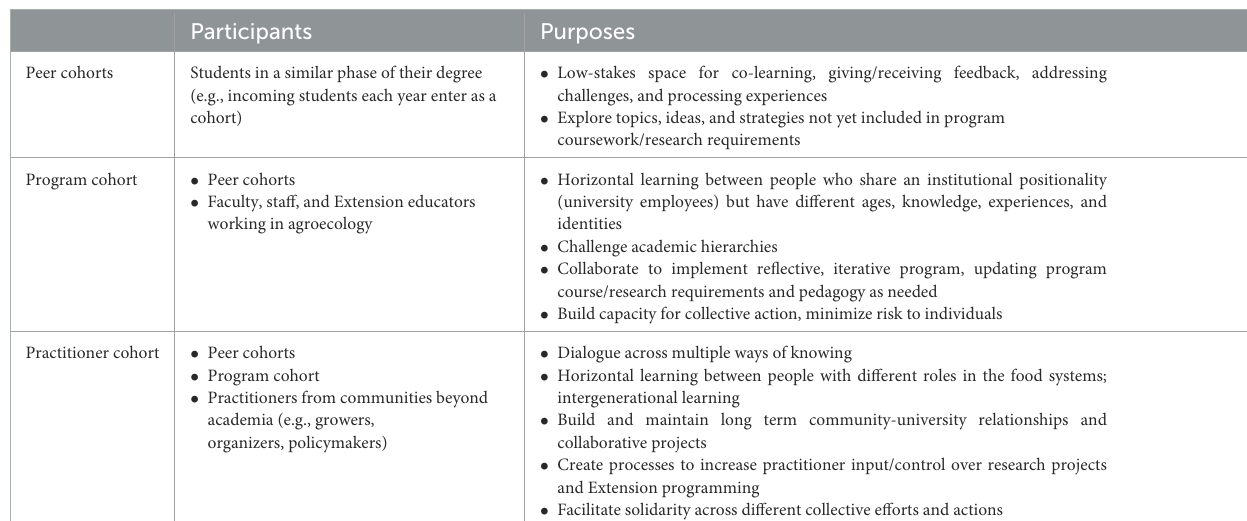
TABLE 3 Brief overview of cohort groups, participants, and